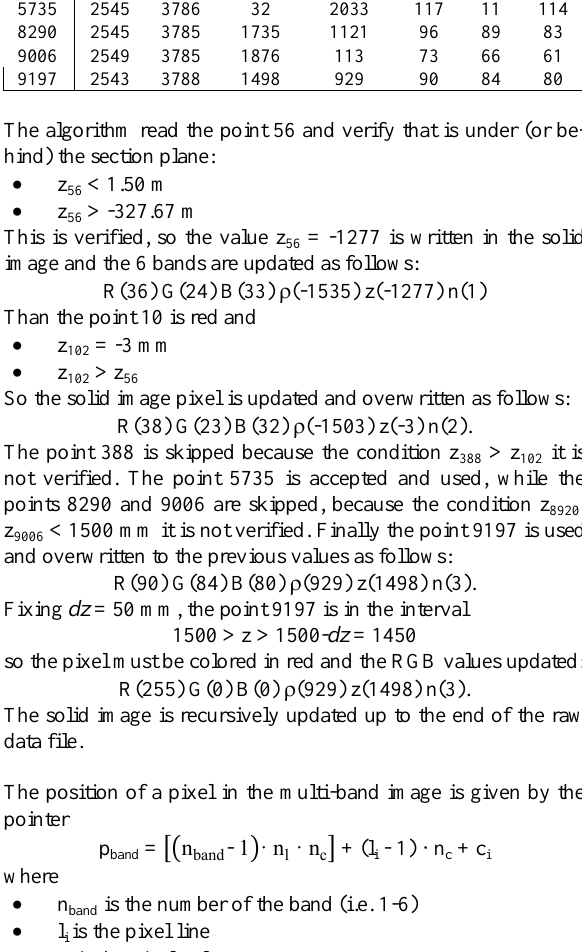
Figure 3. Cross section from the mesh surface model